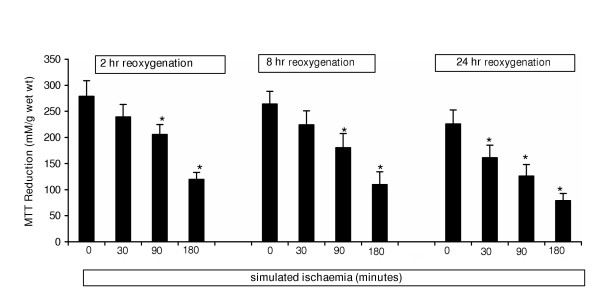
MTT reduction of right atrial muscles subjected to various periods of simulated ischaemia followed by various periods of reoxygenation. The columns represent the mean of 8 experiments and the bars represent the SEM. *p < 0.05 vs aerobic control.